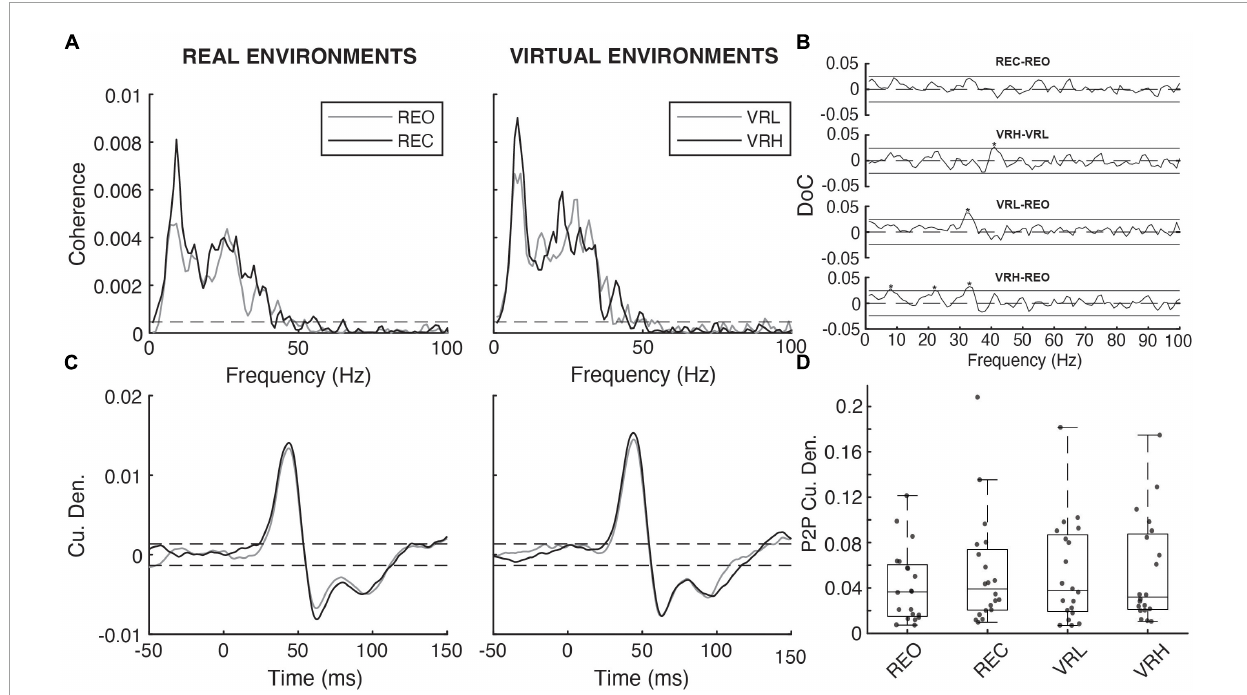
FIGURE5 Noisy tendon vibration evoked responses across real and virtual conditions. (A) Pooled coherence spectral estimates ( N = 20) under real (REO vs. REC) and virtual (VRL vs. VRH) visual environments. (B) Pairwise difference of coherence (DoC) tests comparing the pooled coherence spectra under real (REC-REO) and virtual (VRH-VRL) conditions. Comparisons between baseline (REO) and virtual (VRL-REO, VHR-REO) visual conditions are also shown. Solid horizontal black lines denote the 95% CI for each pairwise DoC test and values exceeding these lines (asterisks) indicate that, in all cases, NTV-muscular coherence was higher under conditions of greater postural threat. (C) Pooled cumulant density estimates for the relationship between vibration magnitude and rectified soleus activity under real and virtual visual environments. (D) Individual participant (gray dashed lines/diamonds) and average (black bars) peak-to-peak (P2P) cumulant density